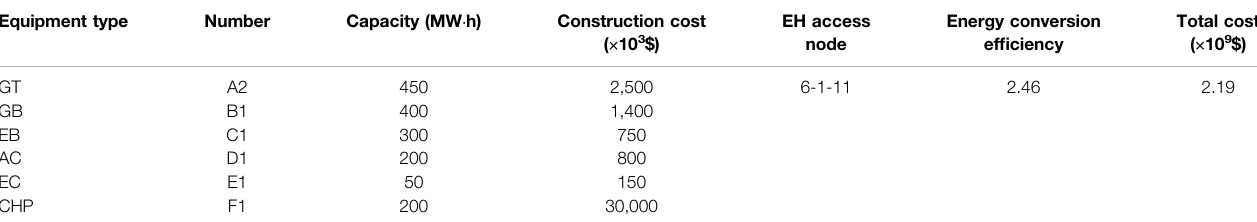
TABLE 5 | EH planning results under